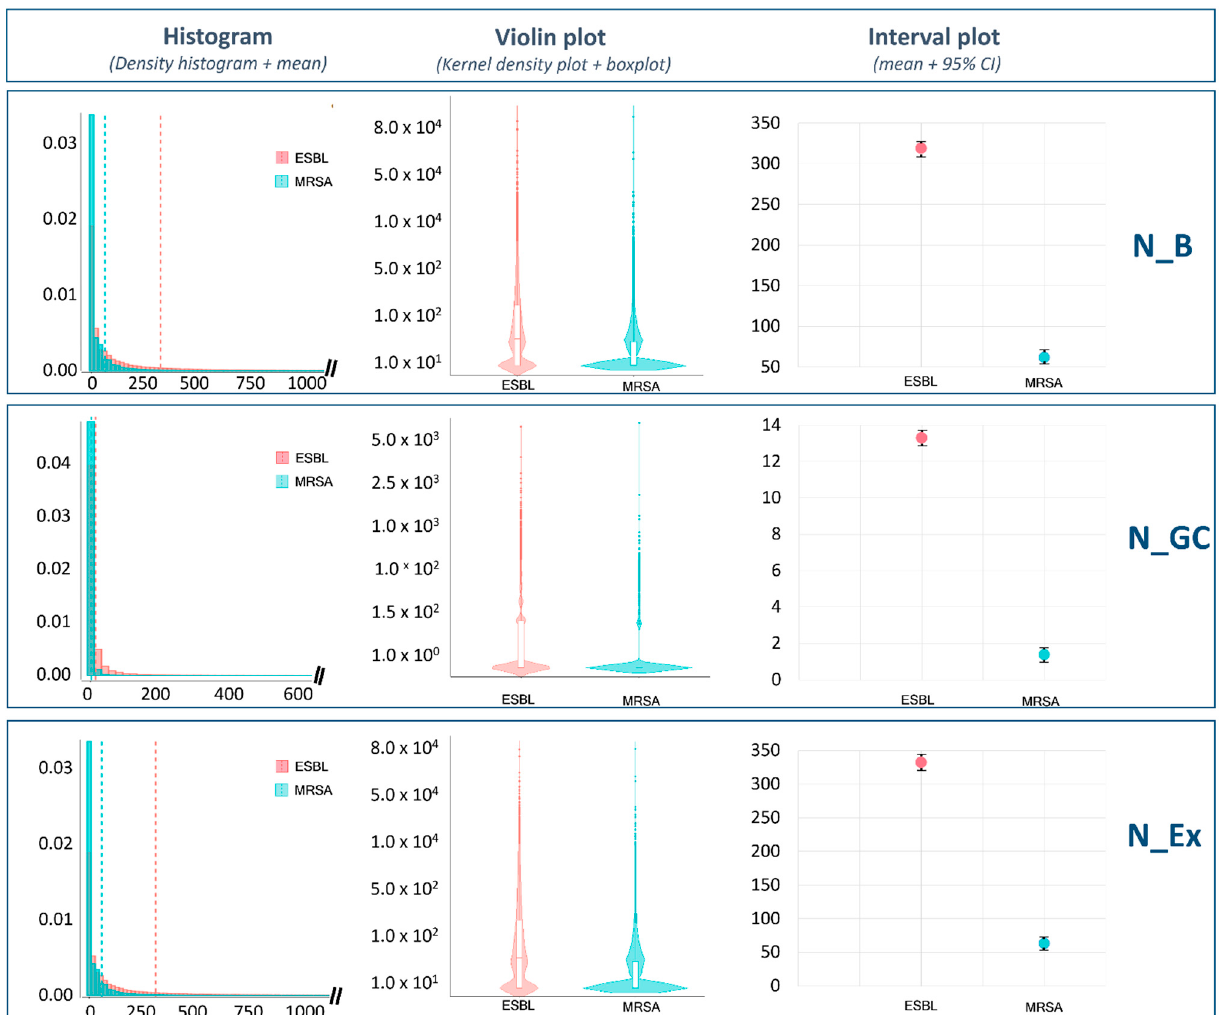
Figure 7. Comparative analysis of consumer exposure between ESBL-/AmpC-producing E. coli and MRSA where the number of CFU transferred to bread (N_B), grilled chicken (N_GC) and the final serving (N_Ex) is graphically represented.